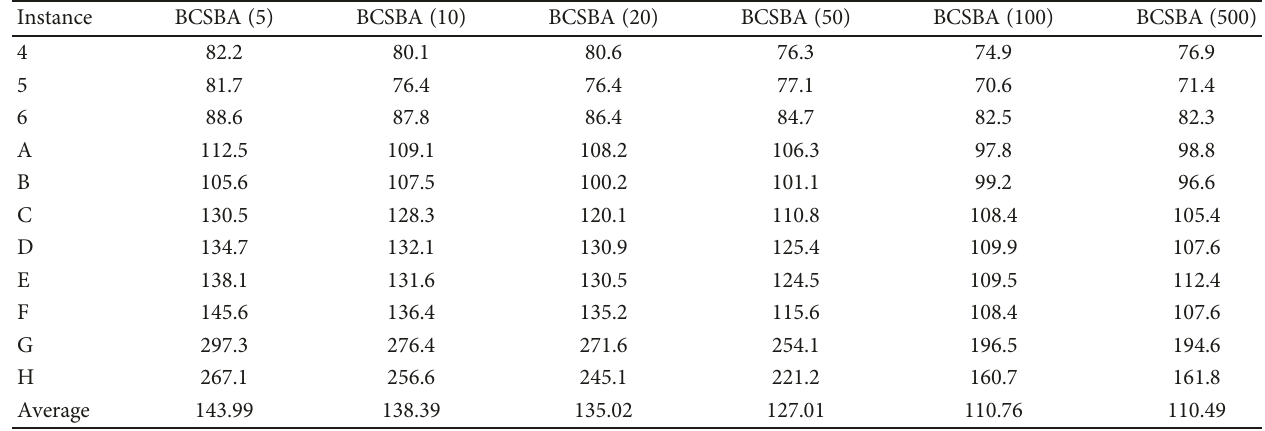
Table 5: Average iteration by problem type.